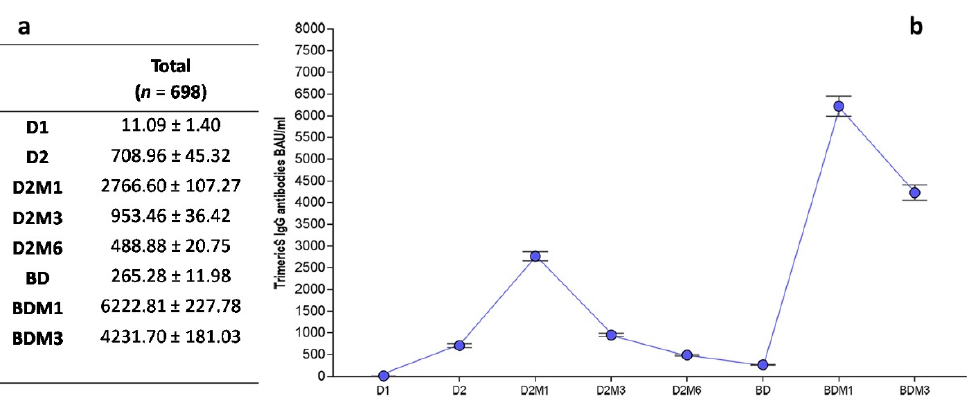
Figure 2. Anti-Trimeric Spike IgG overall mean titer ( a ), and dynamic ( b ) ( n = 698). D1, dose 1; D2, dose 2; D2M1, 1 month after dose 2; D2M3, 3 months after dose 2; D2M6, 6 months after dose 2; BD, booster dose; BDM1, 1 month after booster dose; and BDM3, 3 months after booster dose.